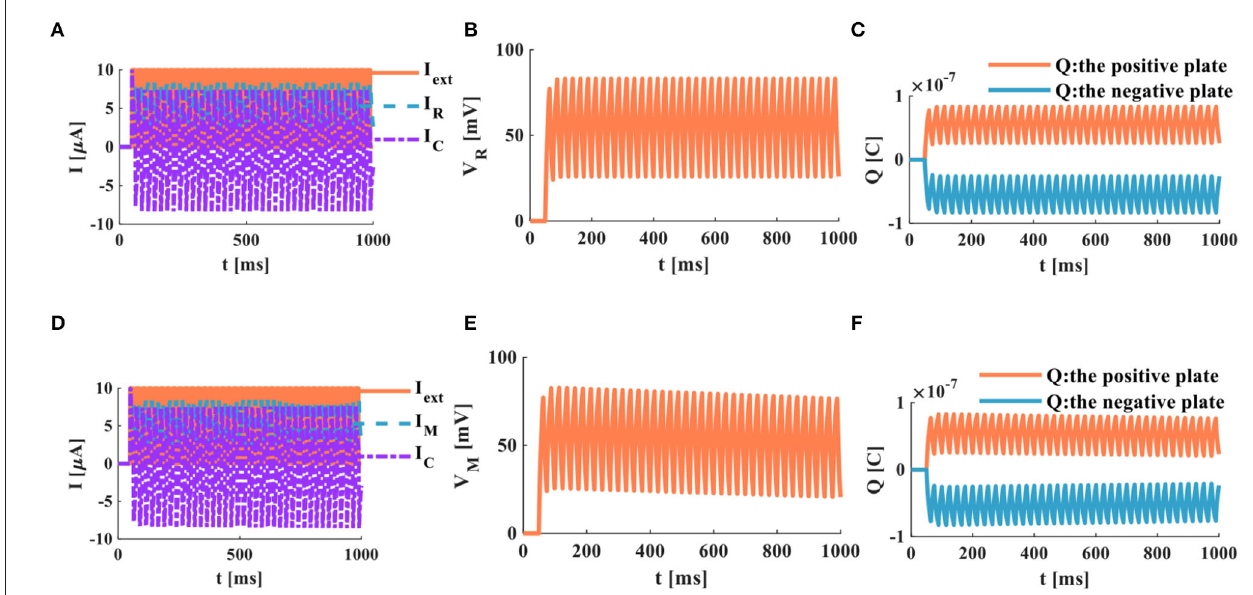
FIGURE 10 | A series of current pulses act on the RC and MC neuron circuits (the number of external stimuli is 38), (A) the current flows through the resistor R and the capacitor C, (B) the membrane potential of the RC circuit, (C) the charges on the positive and negative plates in the RC circuit, (D) the current flows through the memristor M and the capacitor C, (E) the membrane potential of the MC circuit, (F) the charges on the positive and negative plates in the MC